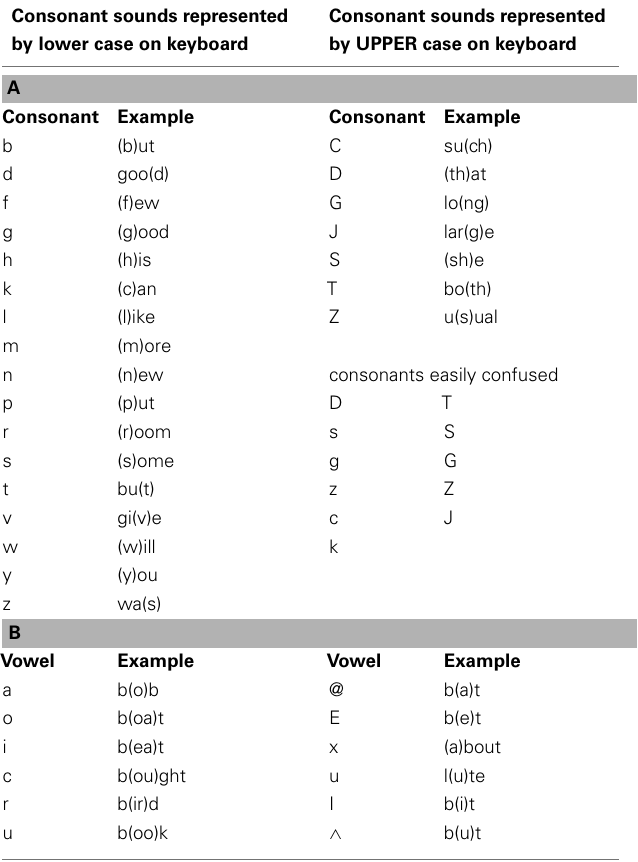
Table 1 | Pre-test and post-test consonant identification lists in single-phoneme transcription format.